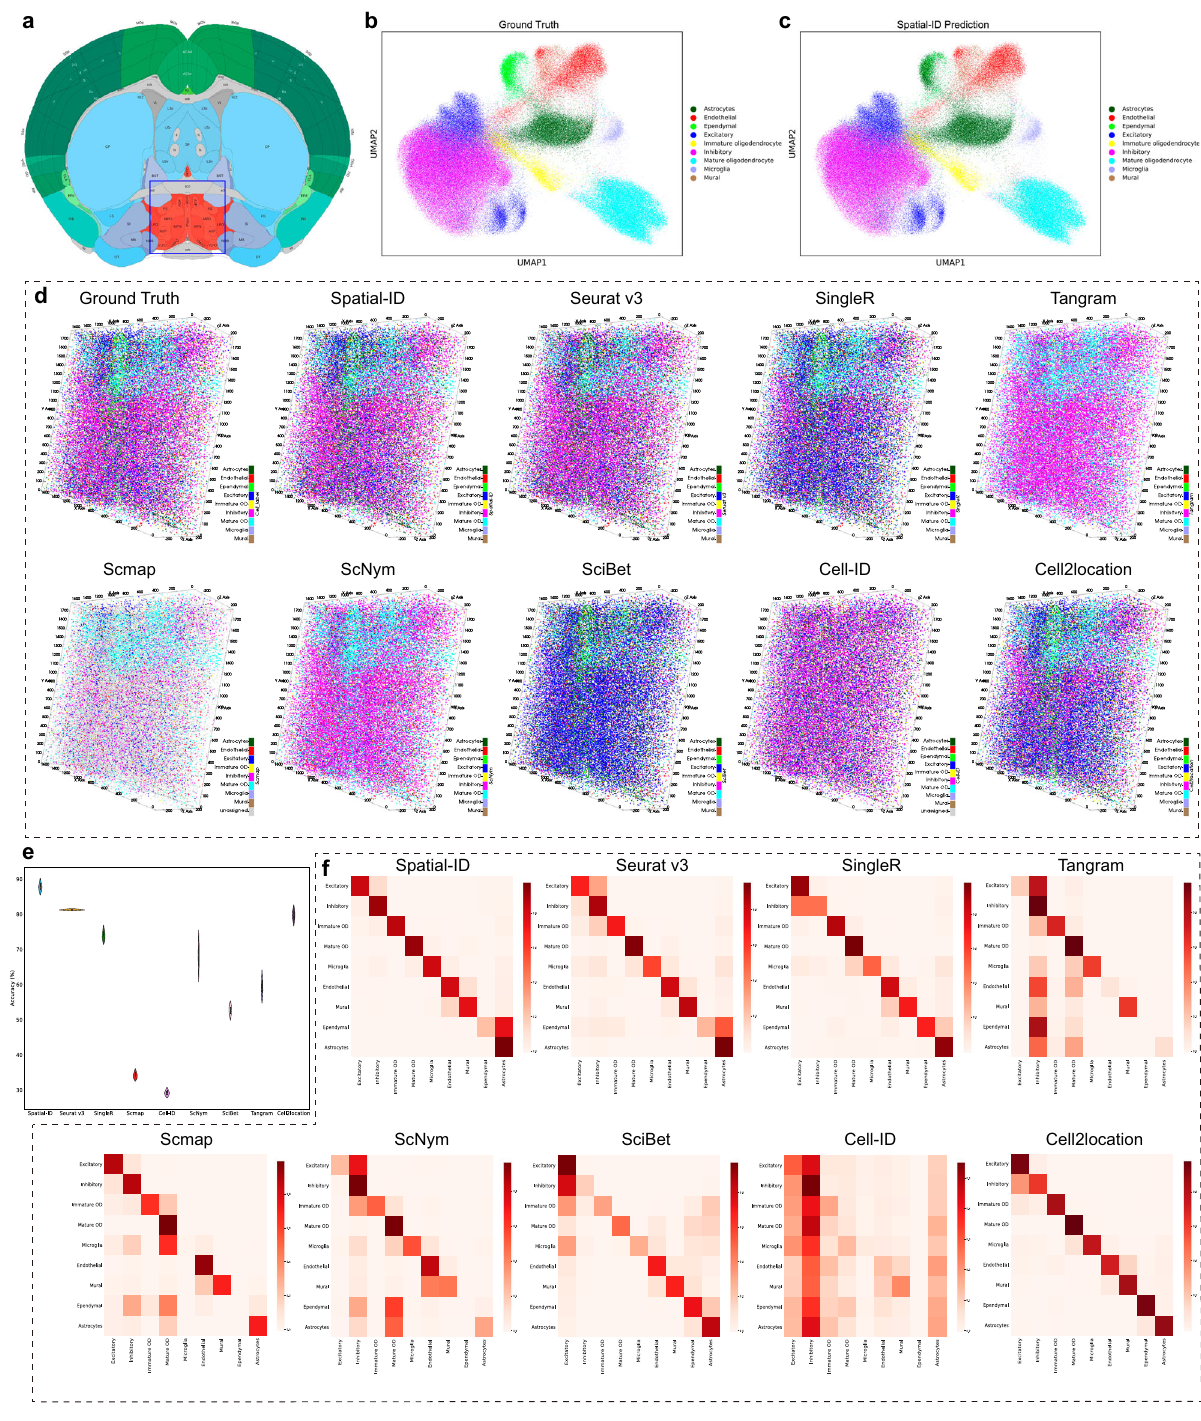
Fig. 3 | Application to mouse hypothalamic preoptic region dataset measured by MERFISH. a The mouse hypothalamic preoptic region annotations in the Allen CCF v3 (http://atlas.brain-map.org/). b Visualization of the ground truth cell types using UMAP embedding. c Visualization of the Spatial-ID predictions using UMAP embedding. d 3Dspatialorganizationofthegroundtruthcelltypesofasamplewith